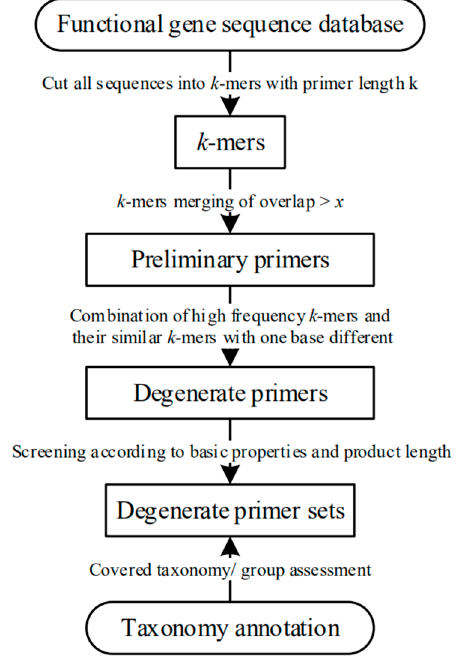
Figure 1. Workflow for primer design process.